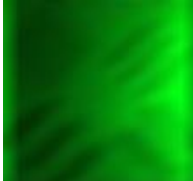
Figure 2. Sample image.